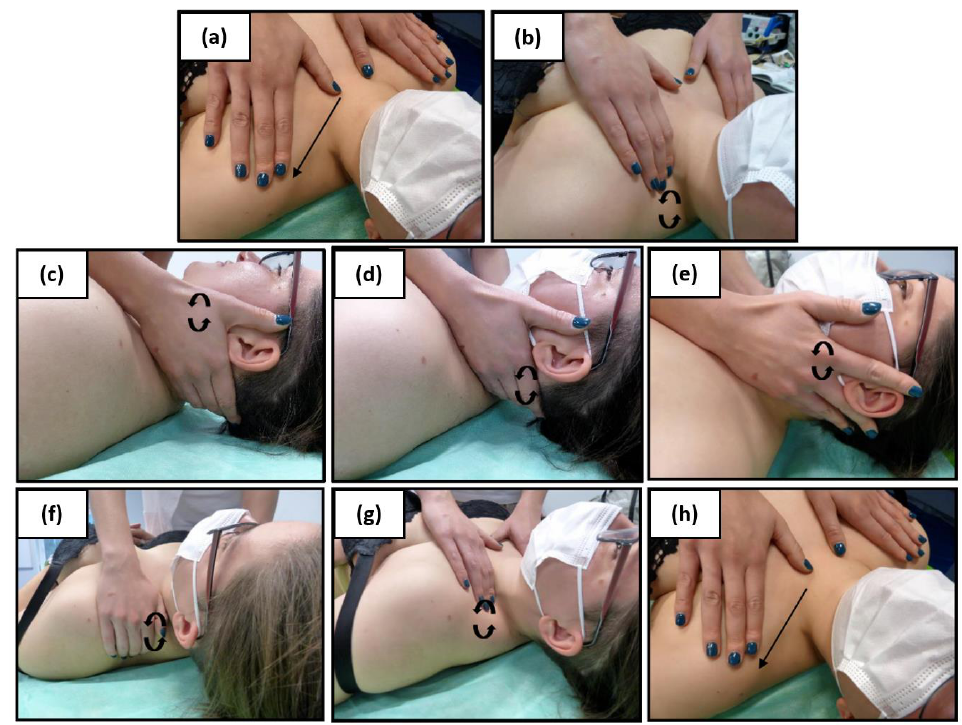
Figure 3. Pretreatment: Manual lymphatic drainage of the neck; effleurage: superficial strokes from the sternum to the acromion ( a ); stationary circles in the supraclavicular fossa on the lower deep cervical lymph nodes ( b ); stationary circles from the mandibular angle, over the upper and lower deep cervical lymph nodes ( c ); stationary circle along the nuchal line, occipital lymph nodes ( d ); stationary circles in front of and be-hind the ear ( e ); stationary circles from the acromion posteriorly to the spine of the scapula to the supraclavicular fossa ( f ); stationary circles in the supraclavicular fossa ( g ); superficial strokes from the sternum to the acromion ( h ).